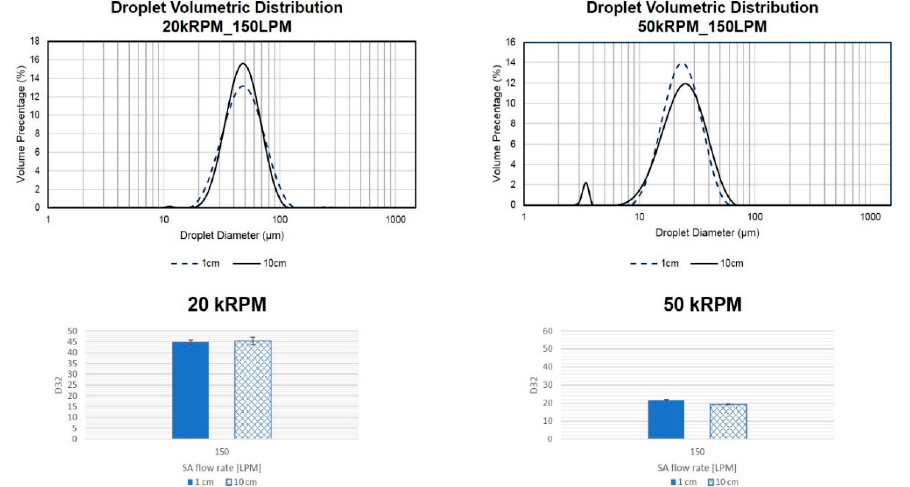
Figure 8. Droplet volumetric distributions versus droplet sizes and Sauter mean diameters at two locations downstream of the cup for a liquid flow rate of 0.1 LPM, a SA flow rate of 150 LPM, and two cup rotational speeds.